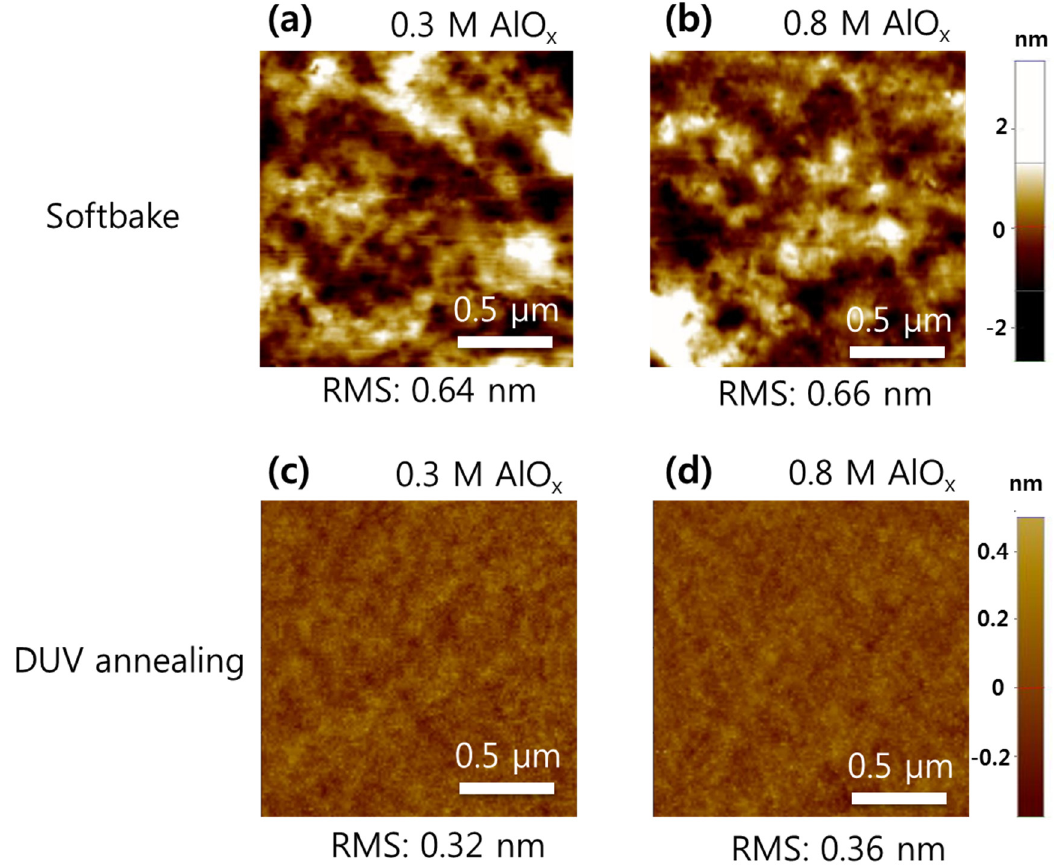
Figure 1. AFM surface scans of ( a , b ) softbaked and ( c , d ) DUV-annealed AlO x dielectric layers formed with 0.3- and 0.8-M AlO x sol-gel concentrations, respectively.